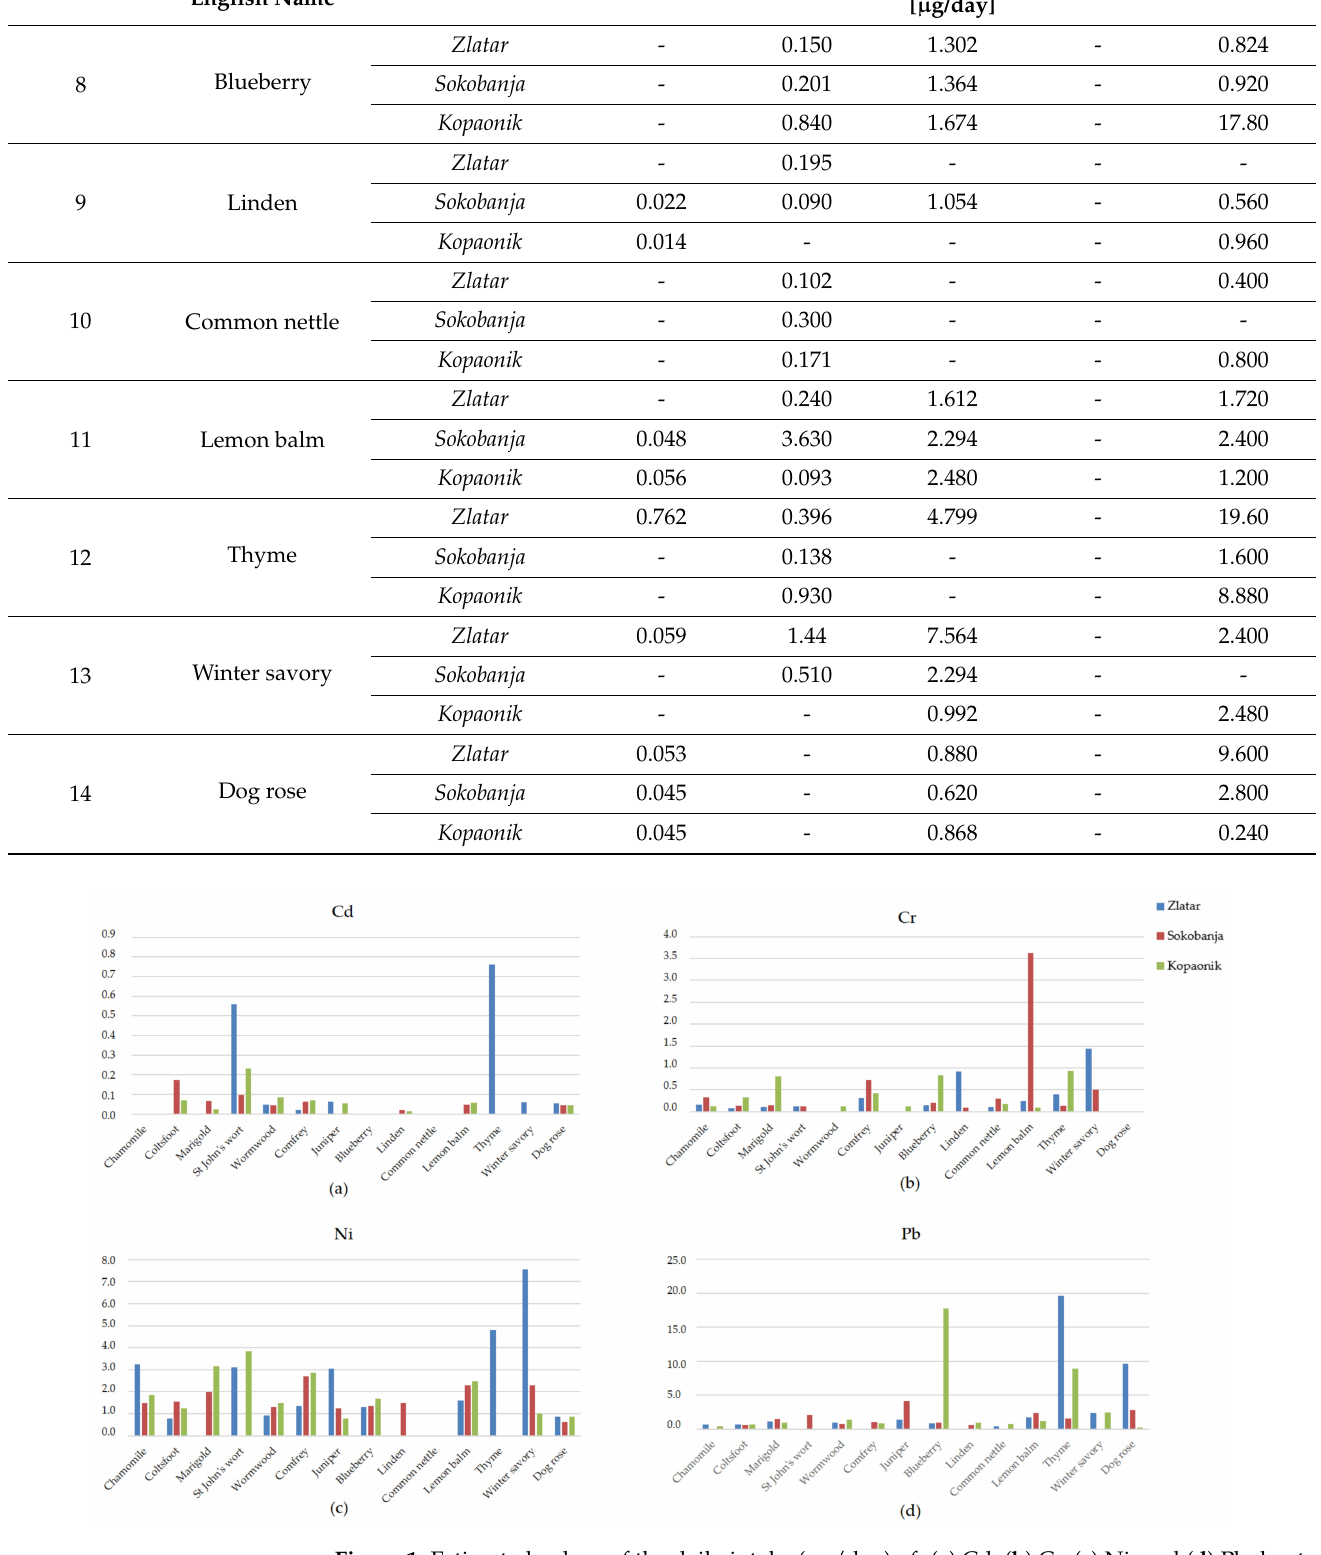
Figure 1. Estimated values of the daily intake ( µ g/day) of: ( a ) Cd, ( b ) Cr, ( c ) Ni, and ( d ) Pb due to ingestion of the 200 mL herbal infusion made from the investigated medicinal